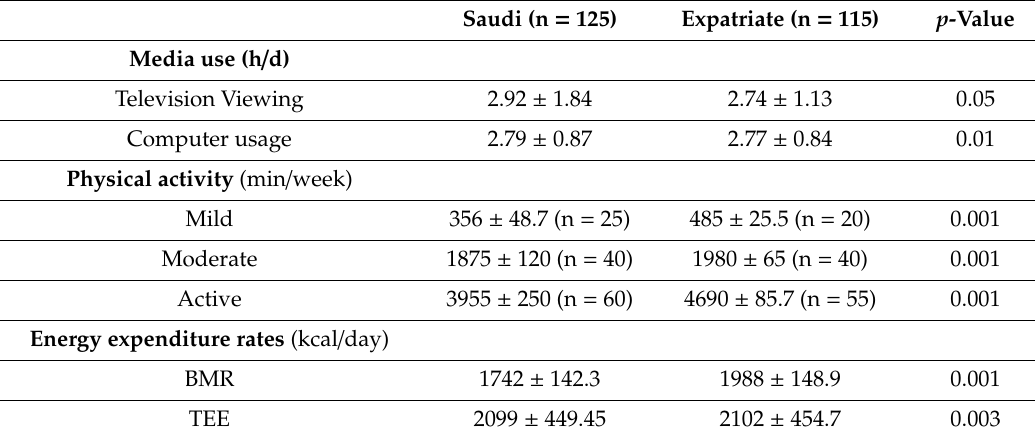
Table 2. Sitting time associated with media use and Physical activity pattern among Saudi and Expatriate